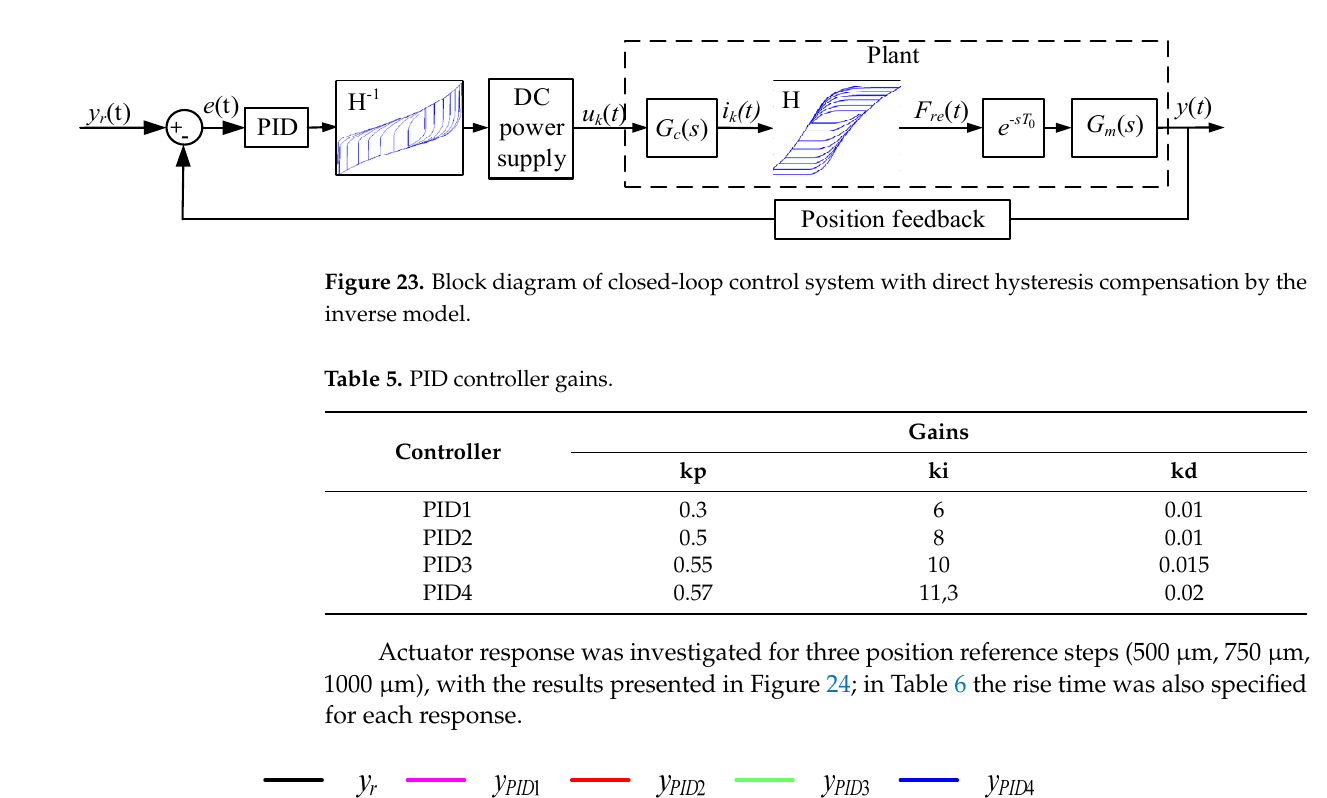
Figure 22. Step responses of actuator and simulation model described by Equation (23).